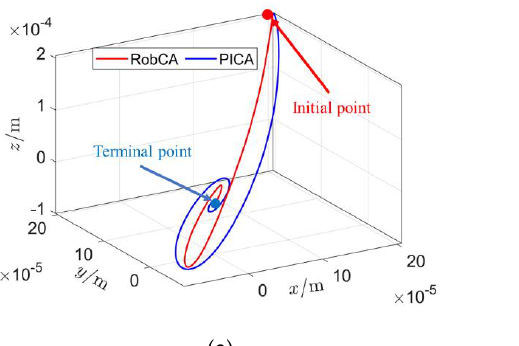
( d ) Angular velocity on ϕ . ( e ) Angular velocity on θ. ( f ) Angular velocity on ψ.